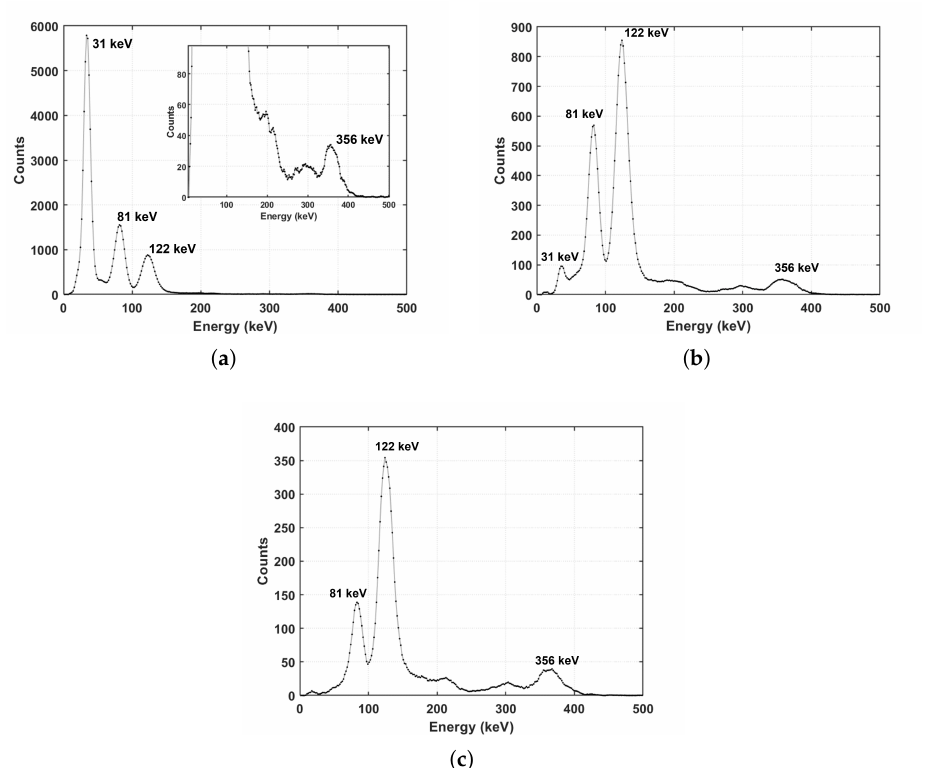
Figure 12. Gamma-ray spectra resulting for the next three depth regions identified from the N / I parameter distribution. ( a ) Spectrum resulting from the selection of events in the second depth region identified from the N / I parameter distributions ( N / I from 15 to 25). A zoom on the 356 keV peak is reported, too. ( b ) Spectrum resulting from the selection of events in the third depth region identified from the N / I parameter distributions ( N / I from 12 to 15). ( c ) Spectrum resulting from the selection of events in the fourth depth region identified from the N / I parameter distributions ( N / I from 5 to